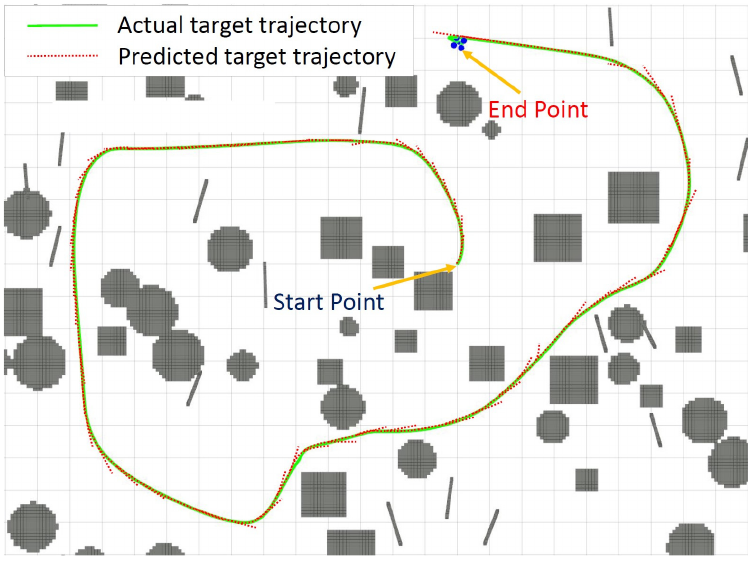
Figure 6. Active and safe aerial tracking experiment in a complex